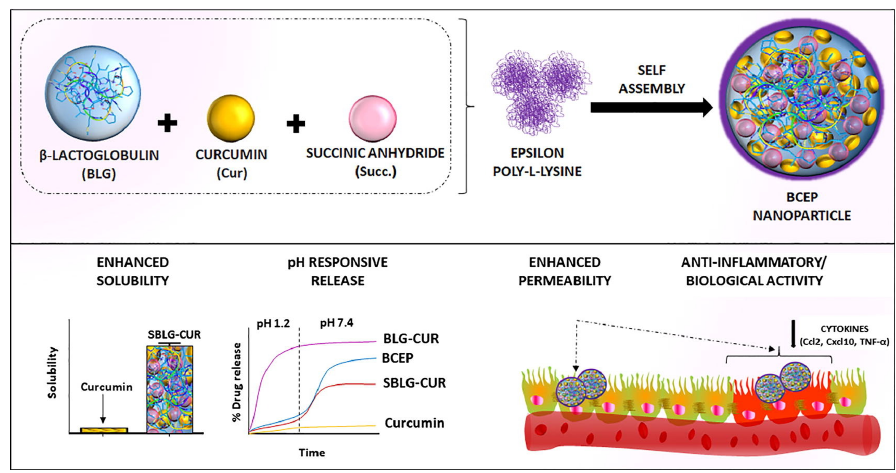
Figure 2. A novel pH responsive nanocolloids based on bovine β -lactoglobulin and succinylated β -lactoglobulin cross-linked with epsilon poly-l-lysine [61]. Copyright 2021 Elsevier. It is also interesting to use amino acid surfactants as components to create hydropho- bic ion pairs (HIP) (Figure 3). In the case of using surfactants as counterions, the drug hydrophobicity can be significantly increased by masking the drug charge with lipophilic surfactant tails [62]. This promotes the inclusion of drug molecules in surfactant-based nanocontainers, which can improve their oral bioavailability